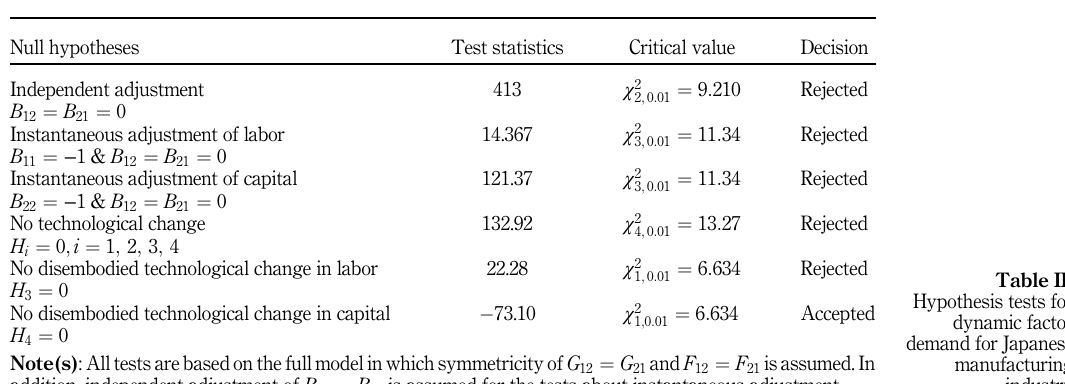
Table II. Hypothesis tests for